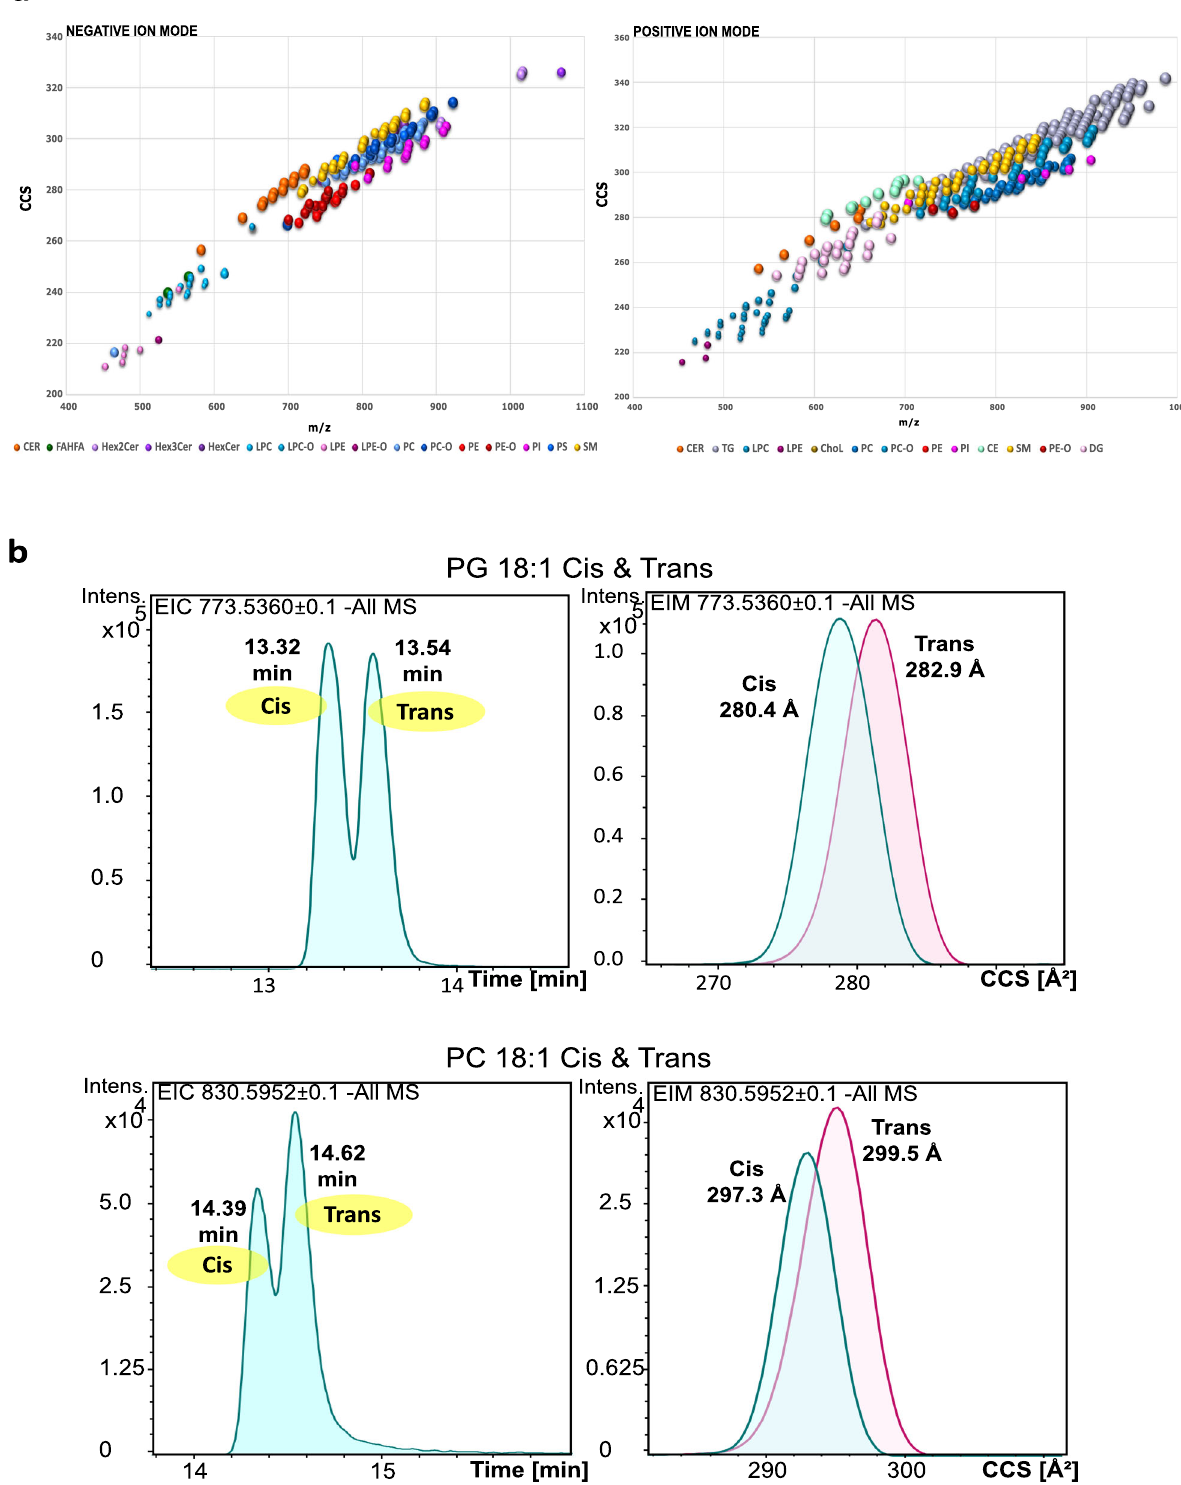
Fig. 2 | Comparison of chromatographic vs mobility separation. a Three- dimensional( m/z , collisionalcrosssection (CCS),retention time(RT)(bubblesize) distribution of identi fi ed lipids from NIST human plasma standard reference material (SRM) in negative (left) and positive (right) ion mode (average value of each dimension from n =32 sample measurements in each mode).